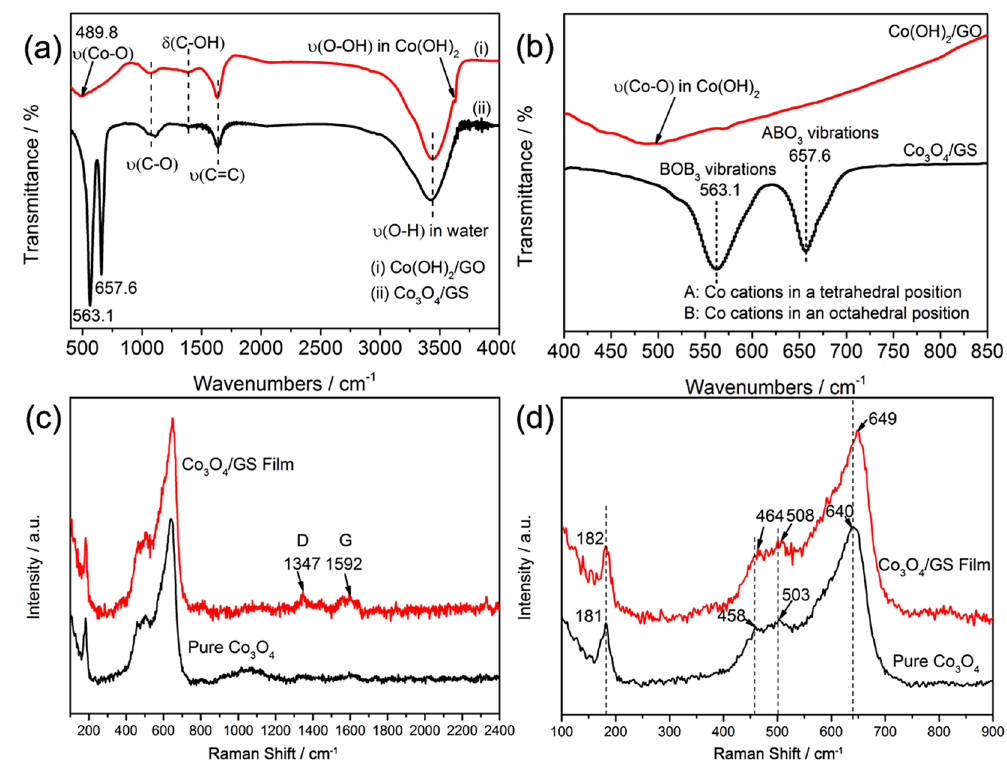
Figure 3. ( a ) FTIR spectra and ( b ) the enlarged spectra of Co(OH) 2 /GO and Co 3 O 4 /GS hybrid films. ( c ) Raman spectra and ( d ) the enlarged Raman spectra of pure Co 3 O 4 and Co 3 O 4 /GS hybrid